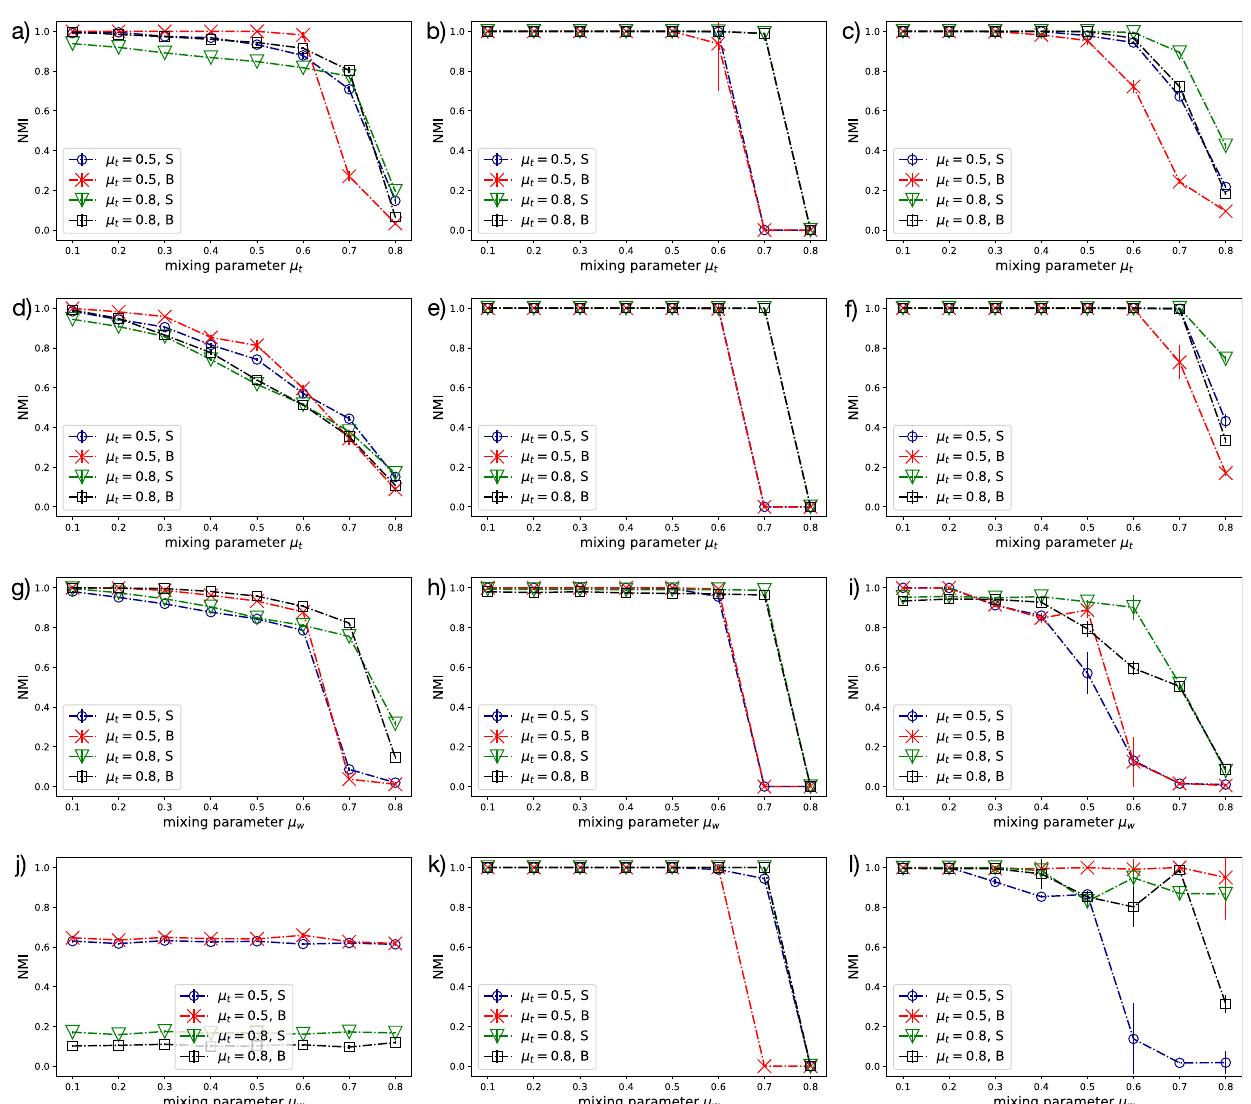
Fig. 4 Comparison of different community detection algorithms on the Lancichinetti – Fortunato – Radicchi (LFR) benchmark. Evolution of the Normalized Mutual Information (NMI) on binary undirected ( a – c ), binary directed ( d – f ), weighted undirected ( g – i ) and weighted directed benchmarks ( j – l ). The algorithms considered here are based upon modularity ( a , d , g and j ), Infomap ( b , e , h and k ) and surprise ( c , f , i and l ). In every panel four curves are shown: they correspond to two different network sizes (blue and red: 1000 nodes; green and black: 5000 nodes) and, for a given size, to two different ranges for the size of communities, indicated by the letters S (small, communities have between 10 and 50 nodes) and B (big, communities have between 20 and 100 nodes). In the case of weighted networks, all con fi gurations have the same size (5000 nodes) the difference lying in the value of the binary mixing parameter (blue and red: u t = 0.5; green and black: u t = 0.8). When considering binary undirected networks, we have set τ 1 = − 2 and τ 2 = − 1 (the average degree is 20 and the maximum degree is 50). When considering binary directed networks, μ t refers to in-degrees, that are distributed according to a power law while the out-degrees are kept constant for all nodes; the other input parameters, instead, are the same ones used for the undirected con fi gurations. When weighted undirected con fi gurations are considered, an additional mixing parameter is needed, i.e. μ w , accounting for the percentage of a node strength to be distributed on the links that connect it to the nodes outside its own community; the exponent of the strength distribution has been set to 1.5 for all realizations considered here. When weighted directed con fi gurations are considered, μ w refers to in-strengths. The trend of the NMI, plotted as a function of the mixing parameters, reveals Infomap to be a strong performer even if its performance decreases abruptly as the mixing parameters exceed a threshold value that depends on the particular setting of the benchmark; the performance of modularity, instead, degrades less rapidly. The performance of surprise seems to constitute a good compromise between the robustness of modularity and the steadily high accuracy of Infomap. The error bars quantify the variability (standard deviation) of the NMI values over the set of one hundred networks generated for each setting of the